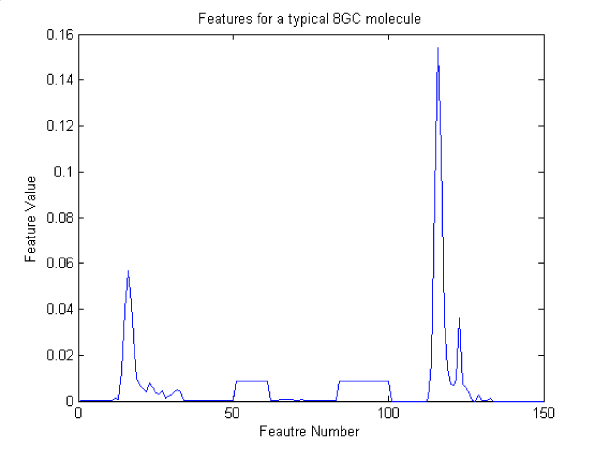
Features for a typical 8GC type molecule.